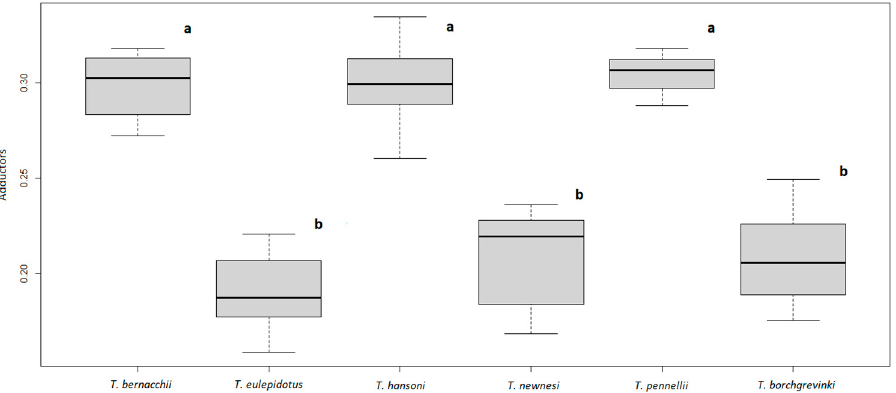
Figure 3. Boxplots of the relative surface of the adductor mandibulae muscle calculated for the six investigated species. Different letters in the boxplots indicate significant differences.